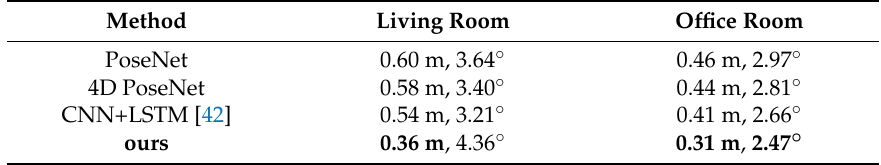
Table 5. Comparison of average pose estimation error in ICL-NUIM dataset.